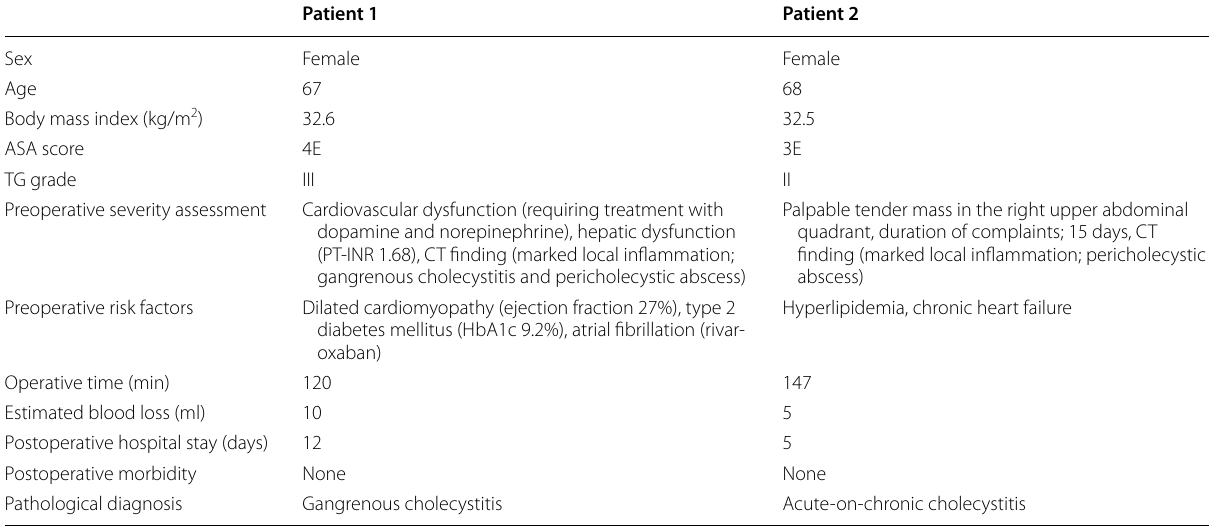
Table 1 Clinical characteristics and perioperative